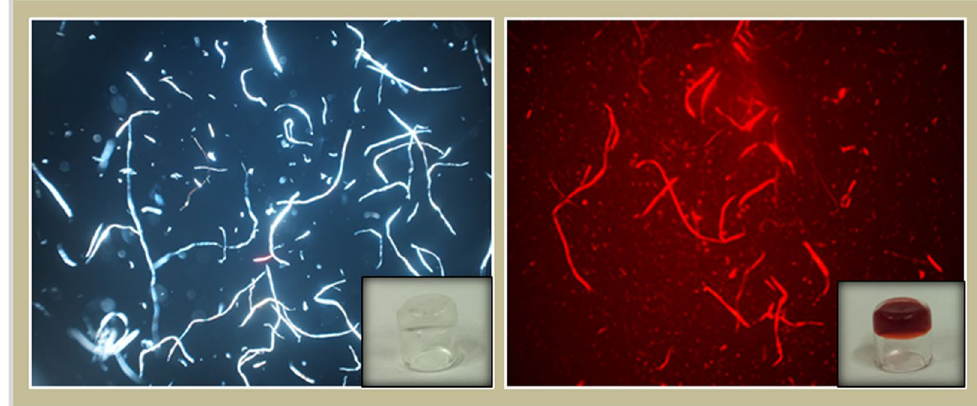
Figure 10. Polarized optical microscopy image of 1-cm vials containing ( a ) Gd-2Nal 2 and ( b ) DOX encapsulating Gd-2Nal 2 hydrogels. Images areobserved with a Nikon